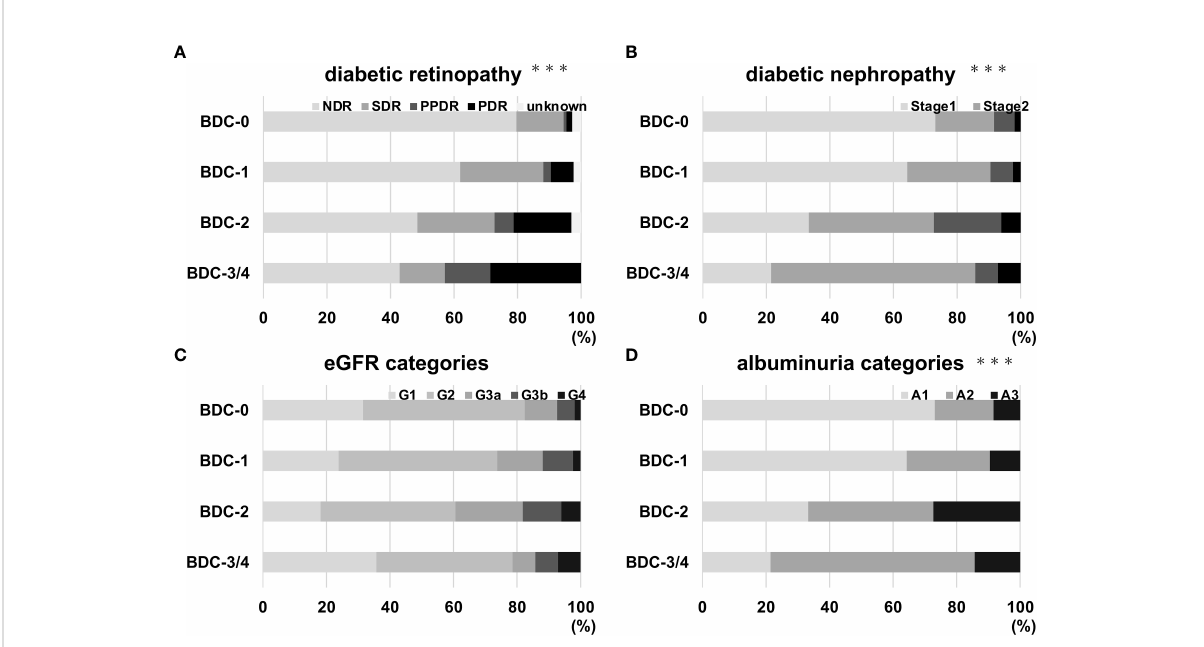
FIGURE 3 Relationship of Baba ’ s diabetic neuropathy classi fi cation (BDC) with diabetic microvascular complications. (A) Correlation between BDC and severity of diabetic retinopathy. (B) Correlation between BDC and severity of diabetic nephropathy. (C) Correlation between BDC and eGFR